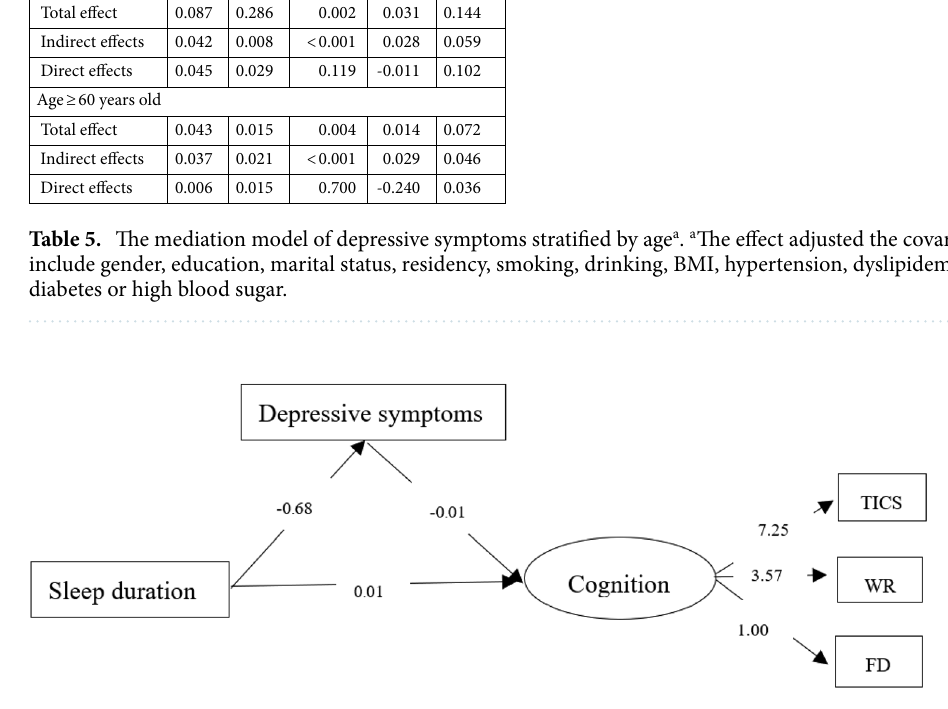
Figure 3. The mediation model of depressive symptoms in the relationship between sleep duration and cognitive function. TICS the telephone interview of cognitive status, WR word recall, FD figure